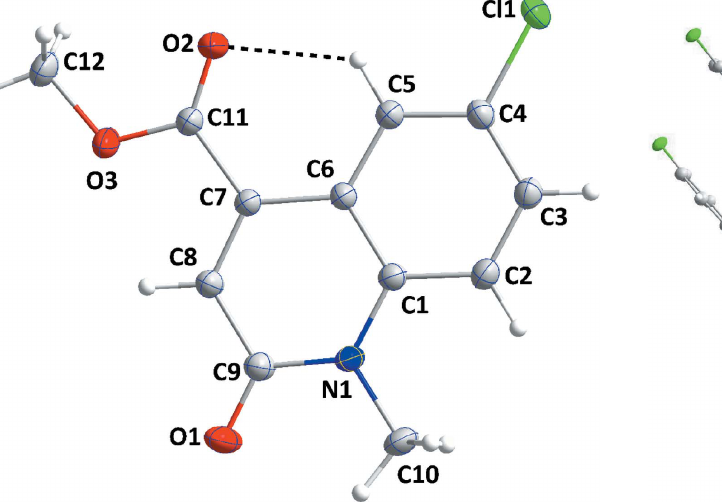
Figure 1 The title molecule with labelling scheme and displacement ellipsoids drawn at the 50% probability level. The intramolecular C—H (cid:3)(cid:3)(cid:3) O hydrogen bond is depicted by a dashed line.